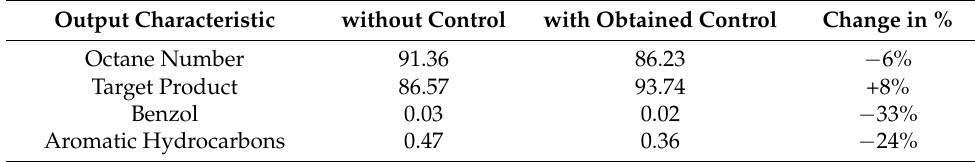
Table 4. Target characteristics of the reaction with and without